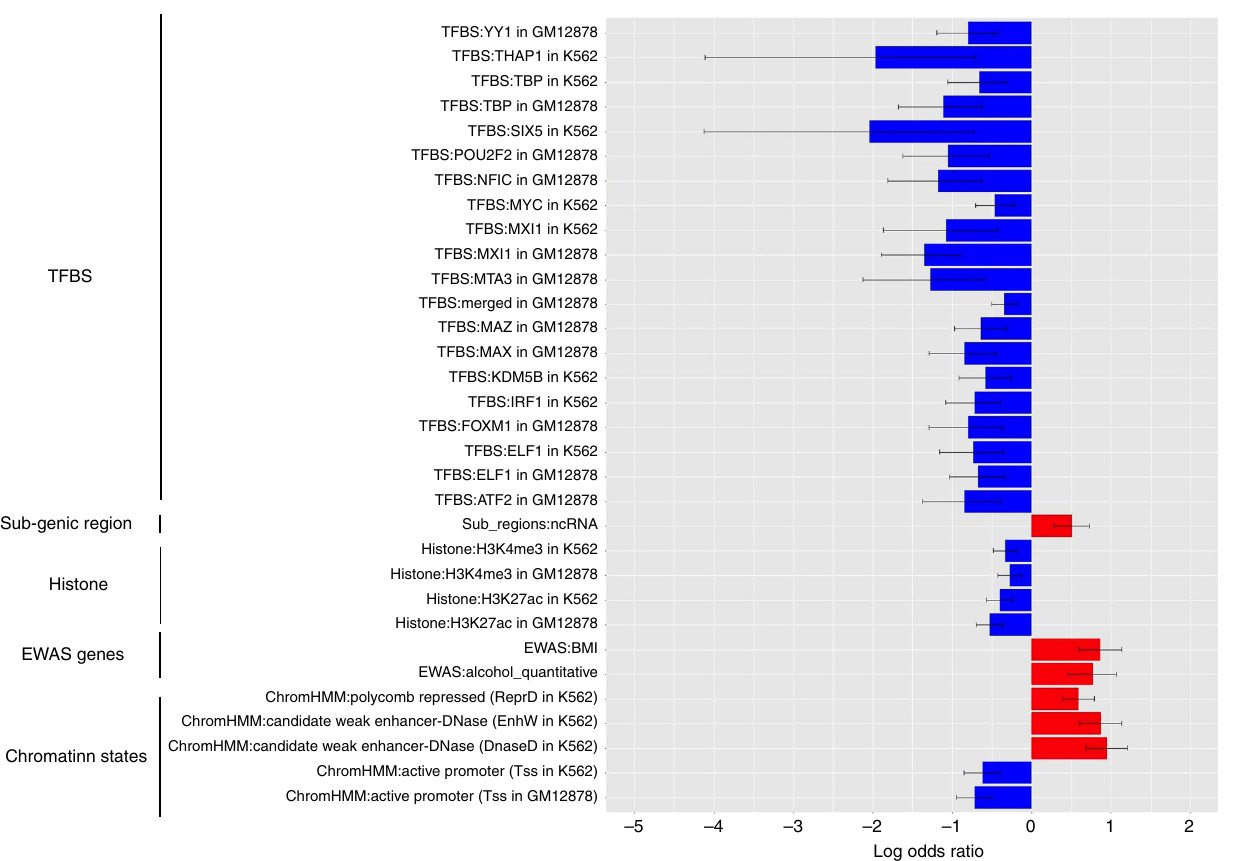
Fig. 3 Genomic annotations signi fi cantly enriched in (red) or depleted of (blue) POE-in fl uenced methylation CpGs. Error bars: 95% con fi dence interval